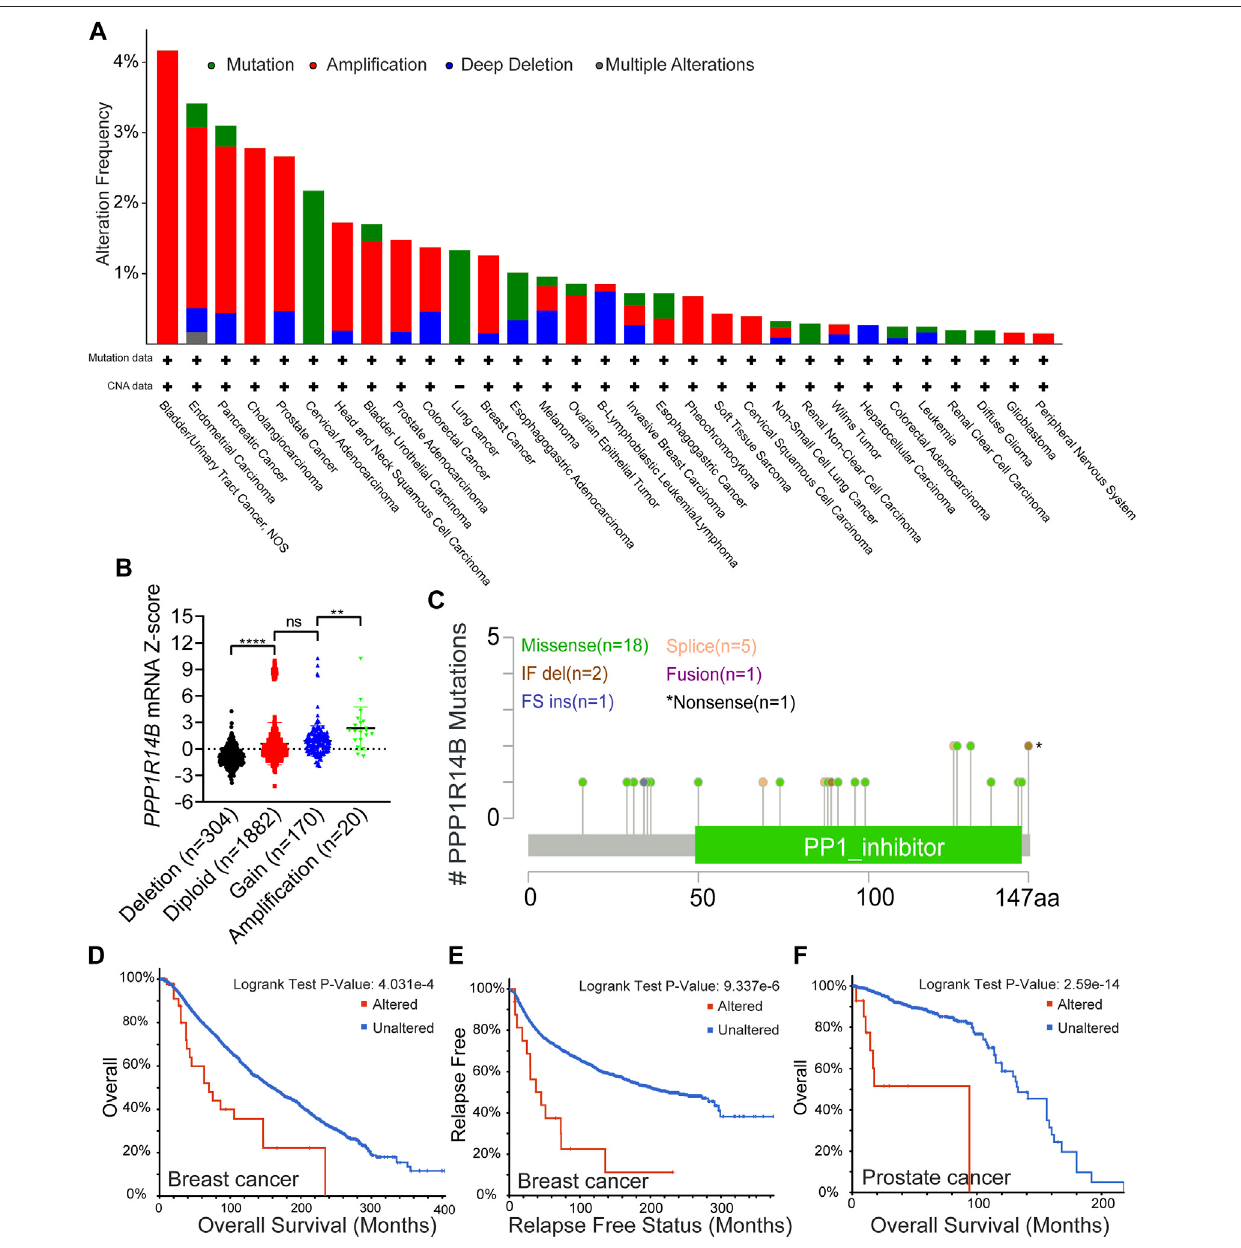
FIGURE 5 | Mutation feature of PPP1R14B in pan-cancer. (A) Alteration frequency with the mutation type of PPP1R14B in human pan-cancer. (B) Association of PPP1R14B copy number alteration with its mRNA expression in the TCGA cancer cohort. (C) Sites and case numbers of the PPP1R14B genetic alteration were presented. (D – F) Association between genetic alteration of PPP1R14B and clinical